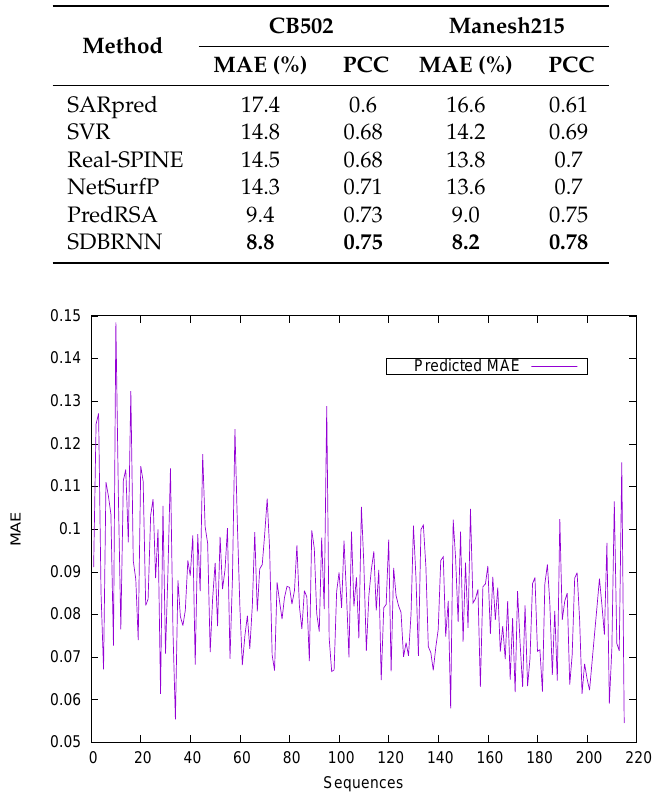
Figure 1. Predicted MAE based-on individual sequence from the Manesh215 dataset. The protein sequences are ordered by sequence